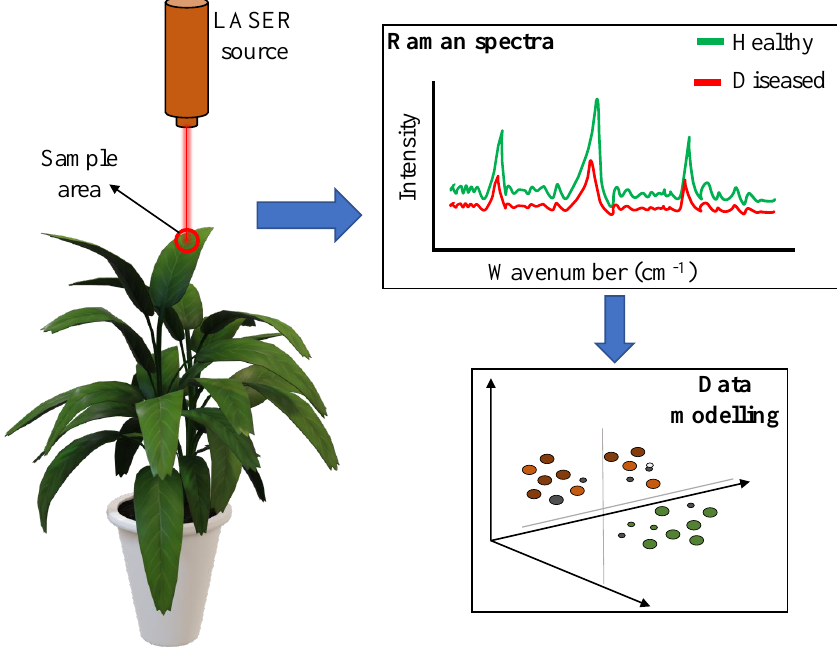
Figure 9. Schematic of Raman spectroscopy-based plant health monitoring